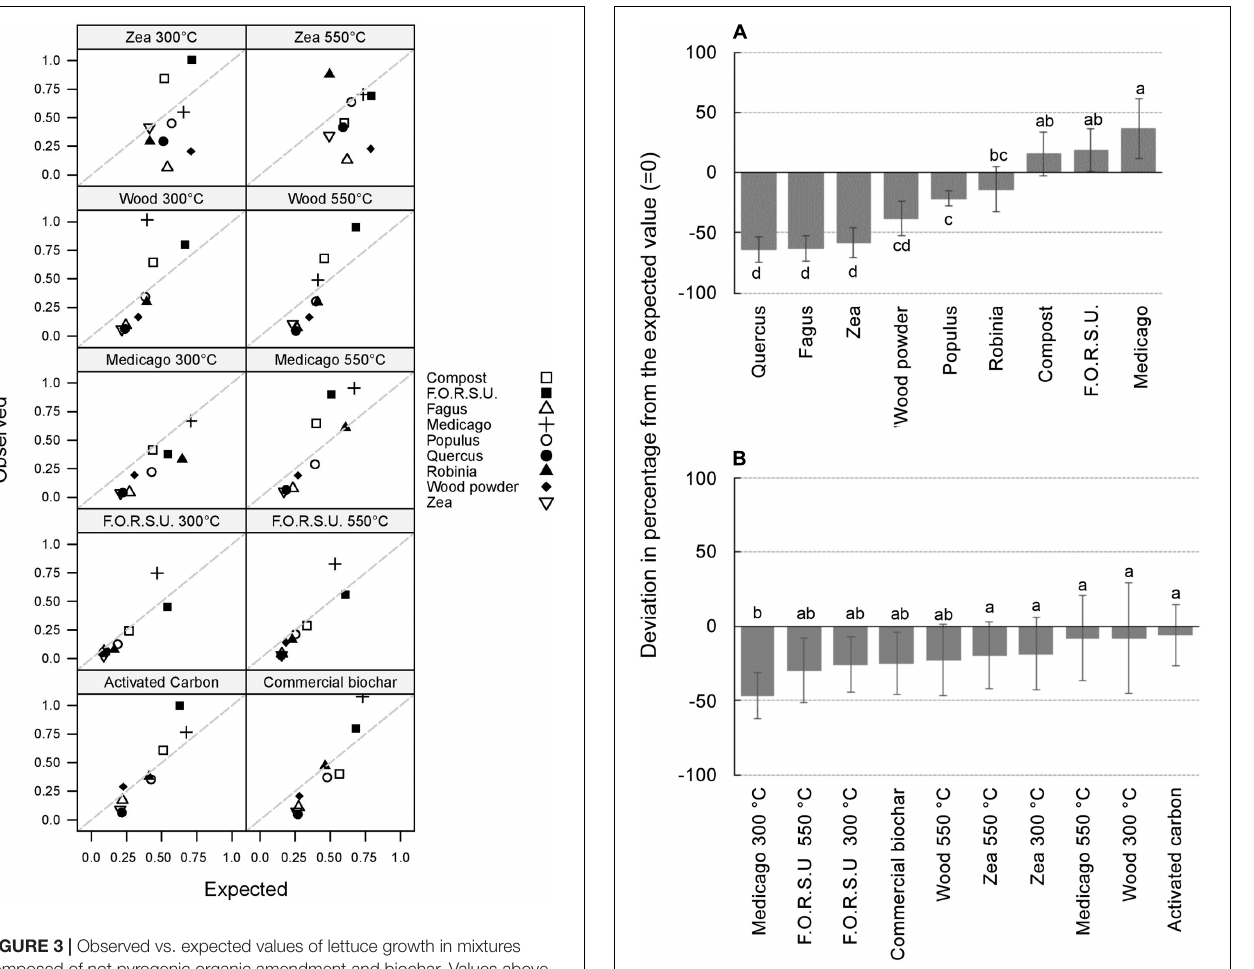
FIGURE 4 | Deviation between observed growths of lettuce in different mixtures compared with the calculated values expected from the growth observed with not pyrogenic organic amendment (NPOA) and biochar used in isolation. In (A) vales are the average of 10 biochar combined with each NPOA type, in (B) values are the average of 9 NPOA combined with each biochar type. Different letters indicate significant differences (Duncan test at P <